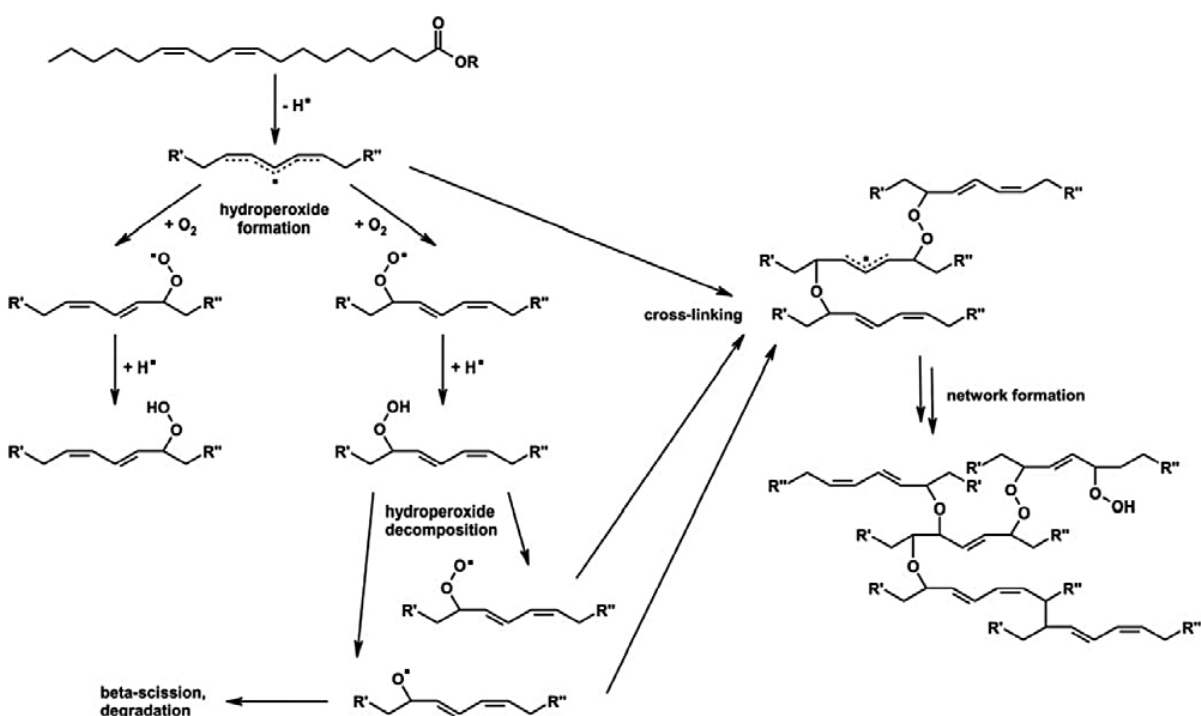
Figure 4. Shematic presentation of the autooxidative curing process in alkyd coatings. 9,16